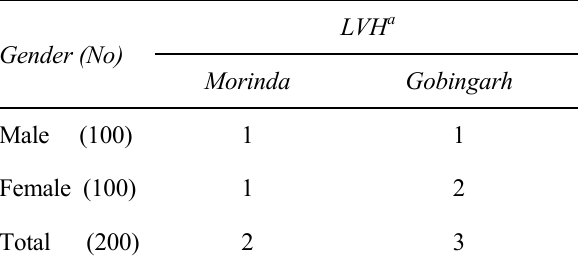
Figure 4c : An abnormal ECG tracing for left ventricular hypertrophy